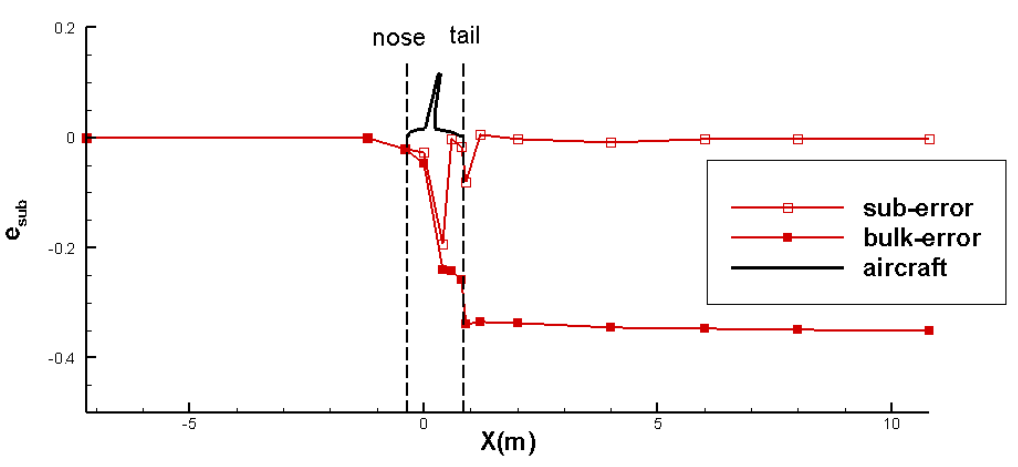
Figure 17. Subdomain error study of BLI configuration.